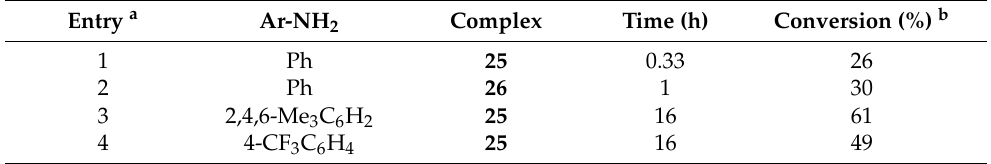
Table 9. Gold-catalyzed intermolecular hydroamination reactions of phenylacetylene with Ar-NH 2 .